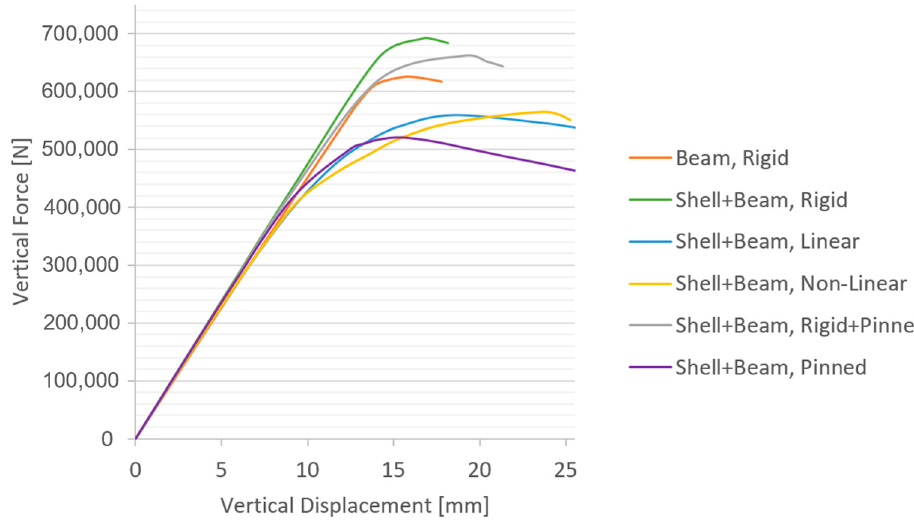
Figure 14. Vertical force–displacement curves of the 3D-subassembly models compared. Table 6. Load capacity of the 3D-subassembly models compared.